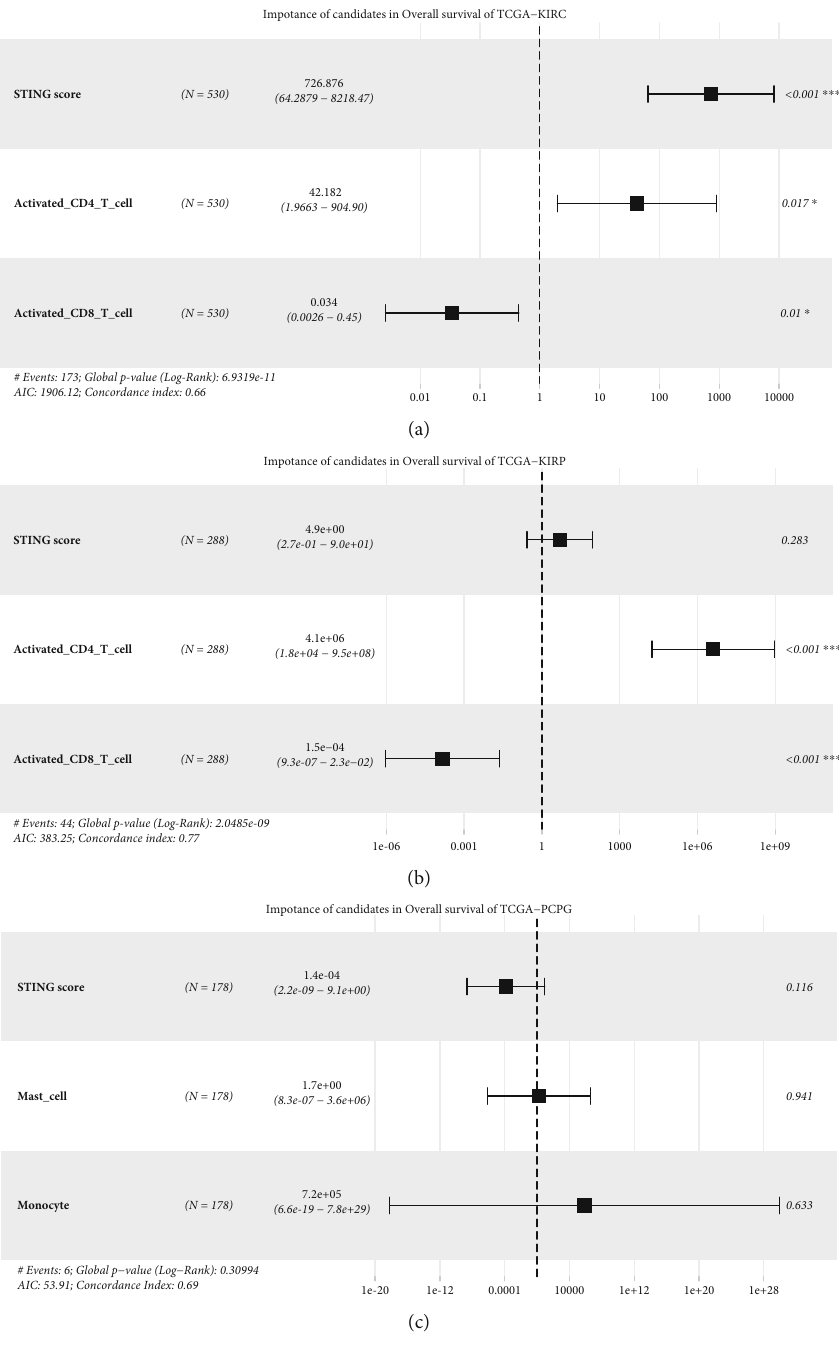
Figure 6: Multivariable Cox regression analysis of the cGAS-STING sensor and TIICs in KIRC, KIRP, and PCPG. (a) Multivariable Cox regression analyses of the cGAS-STING sensor, activated CD4 T cells, and activated CD8 T cells in KIRC. (b) Multivariable Cox regression analyses of the cGAS-STING sensor, activated CD4 T cells, and activated CD8 T cells in KIRP. (c) Multivariable Cox regression analyses of the cGAS-STING sensor, monocytes, and mast cells in PCPG. ∗ P < 0 : 05 ; ∗∗∗ P < 0 : 001